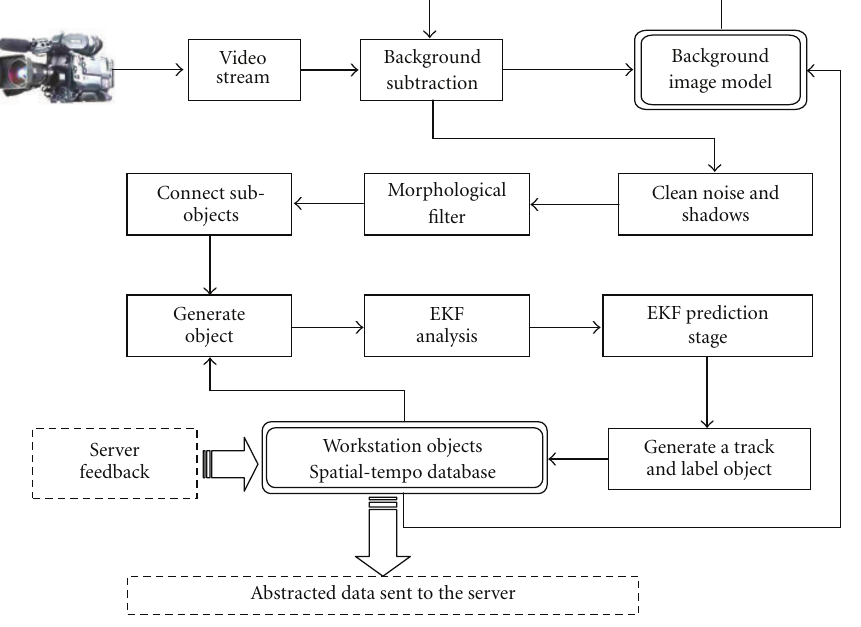
Figure 8: Workstation tracking